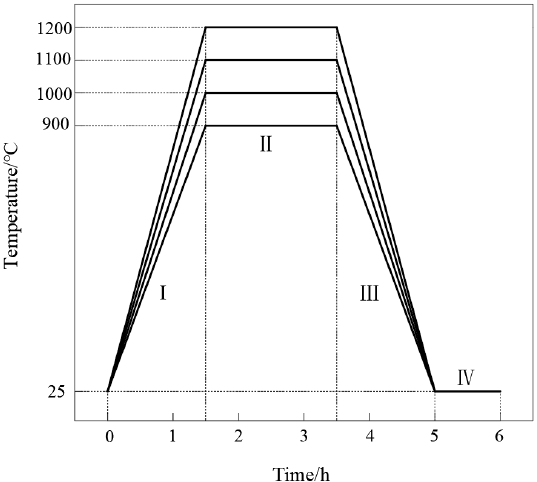
Figure 3. Four coupled analysis steps of temperature displacement at the four highest operating